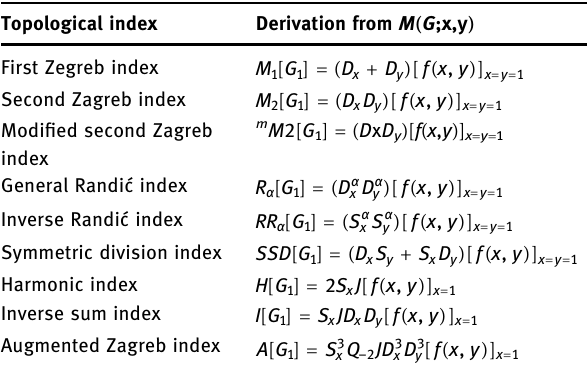
Table 1: Degree - based topological indices